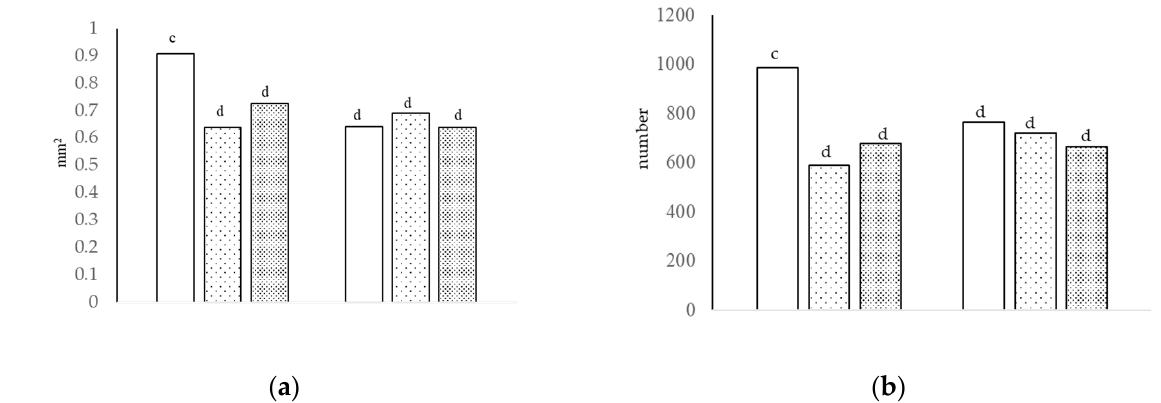
Figure 1. The villi area [( a ), interaction of growth promoter and type of diet, c,d p < 0.05; SEM = 0.045] and number of sulfated acid cells [( b ), interaction of growth promoter and type of diet, c,d p < 0.01; SEM = 51.823] in the jejunum at day 29.